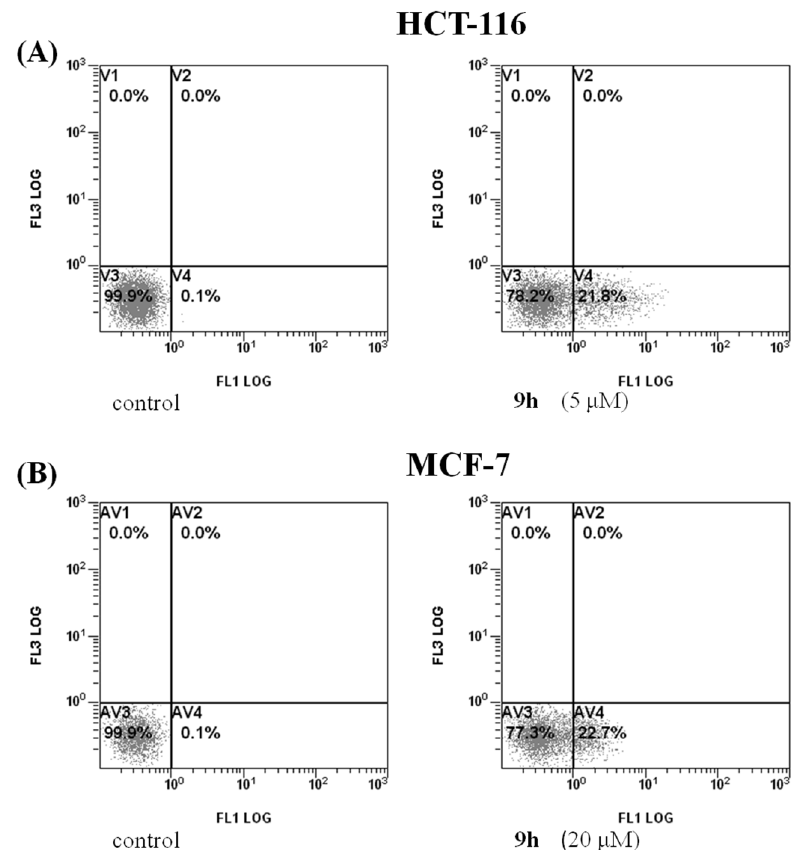
Figure 2. Flow cytometric analysis for the quantification, by annexin V/PI double staining, of 9h derivative-induced apoptosis in HCT-116 ( A ) or MCF-7 ( B ) cells. Cell monolayers were incubated for 24 h in the absence (control) or presence of the synthesized compound at the GI 50 value and